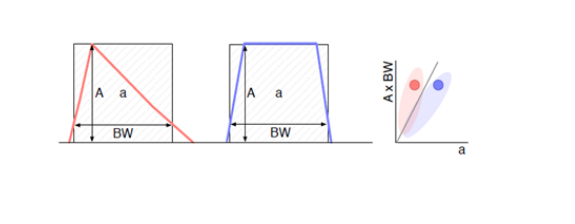
Figure 5. The form factor schematic [11]